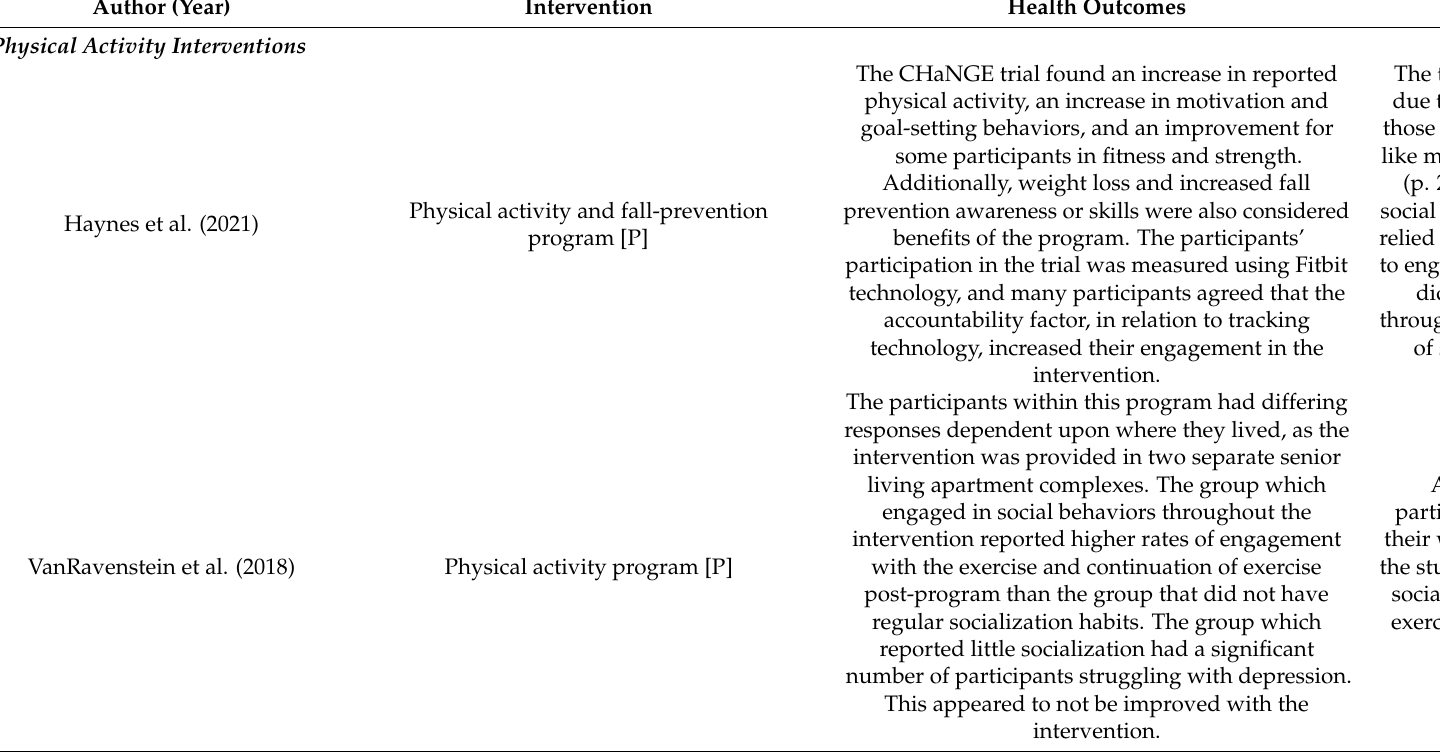
Table A3. Health and social outcomes of qualitative